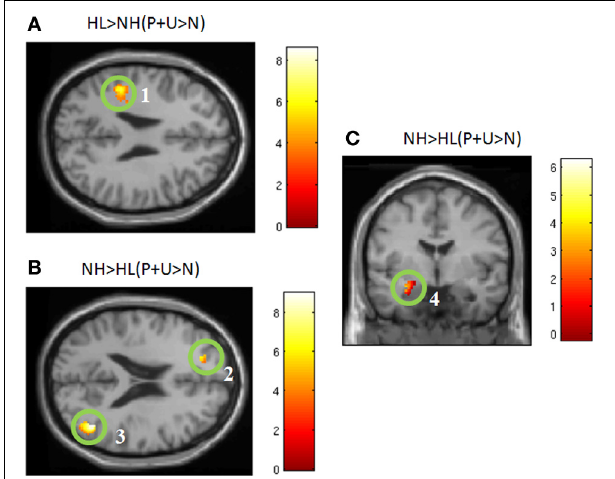
FIGURE 3 | Statistical parametric maps for post-hoc two-tailed two sample t -tests and region-of-interest analysis (ROI). (A) HL > NH (P + U > N) and (B) NH > HL (P + U > N) illustrate the brain regions chosen from the post-hoc two sample t -tests for the seed analysis (MNI coordinate z = + 26, z = + 21, respectively). (C) Denotes increased amygdala activation observed for the NH > HL (P + U > N) comparison (MNI coordinate y = − 4). The maps are displayed at p < 0 . 001 uncorrected level for better visualization, but the clusters in the circles are corrected for multiple comparisons ( p < 0 . 025 FWE). (1) left inferior parietal lobule, (2) left superior frontal gyrus, (3) right middle temporal gyrus, (4) left